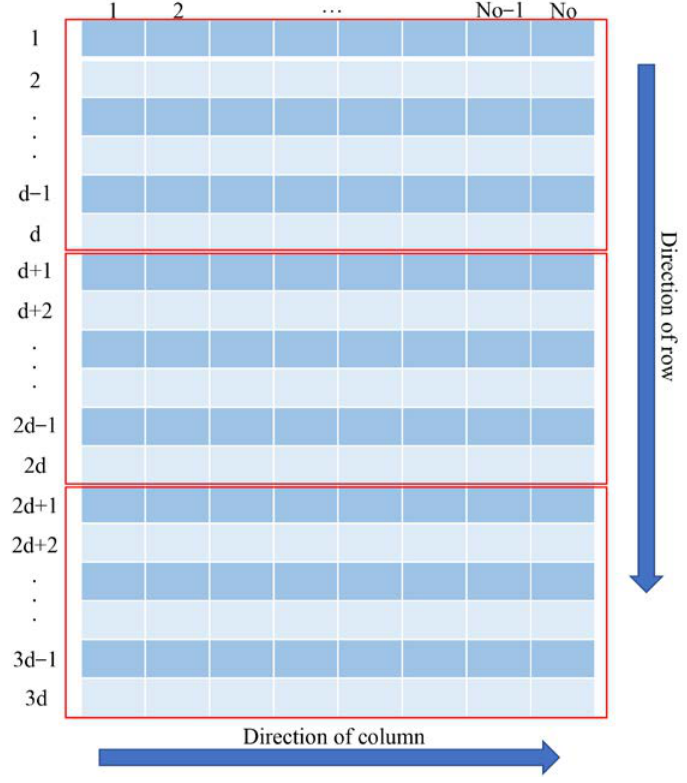
Figure 4. The 2D matrix schematic.